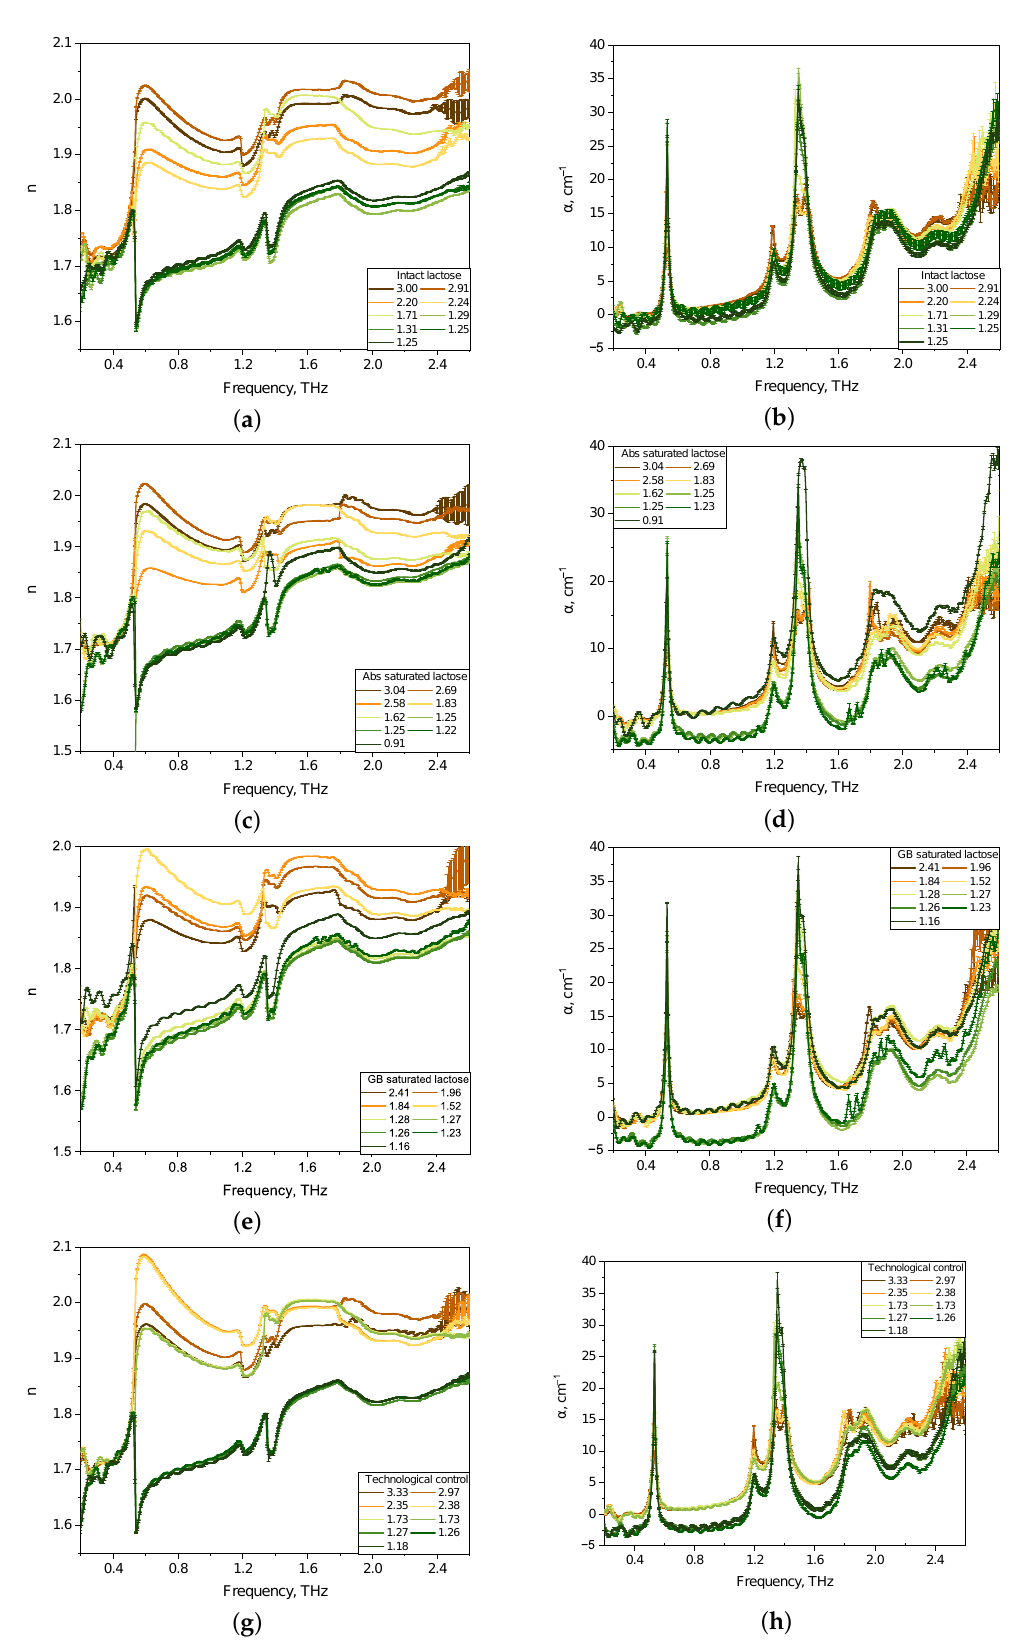
Figure 2. Refractive index ( a , c , e , g ) and absorption coefficient ( b , d , f , h ) spectra in the THz frequency range of lactose tablets with different formulations of various thickness (mm): intact lactose ( a , b ); Abs saturated lactose ( c , d ); GB saturated lactose ( e , f ); Technological control ( g , h